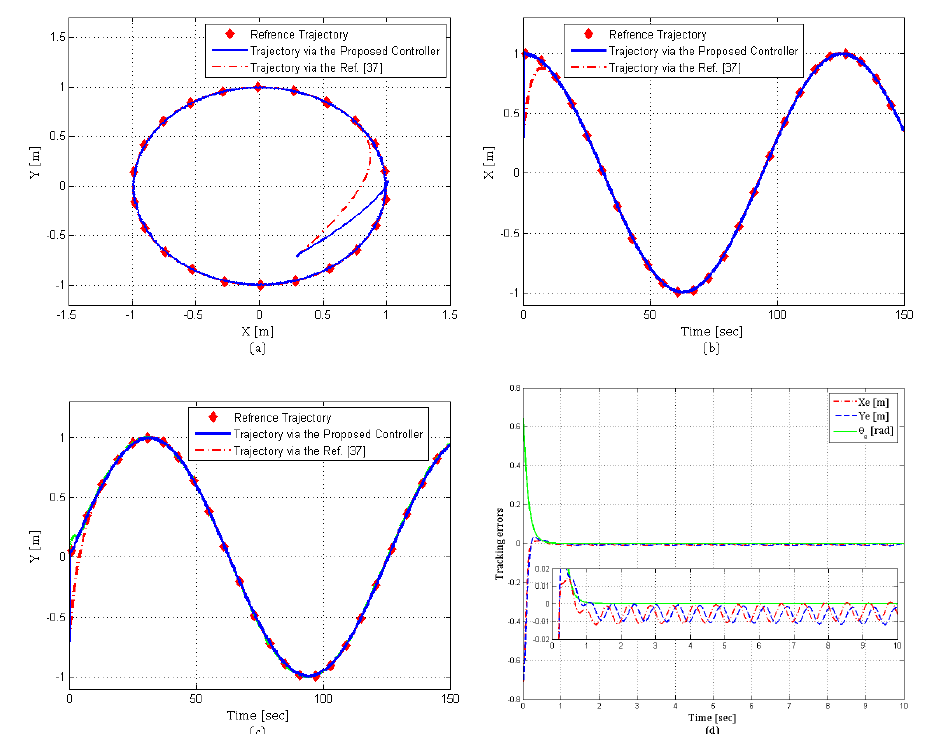
Figure 3. Circular trajectory tracking of WMR. In ( a ) x - y plot. ( b ) Trajectory tracking in x direction. ( c ) Trajectory tracking in y direction. ( d ) Tracking errors ( x e , y e , θ e